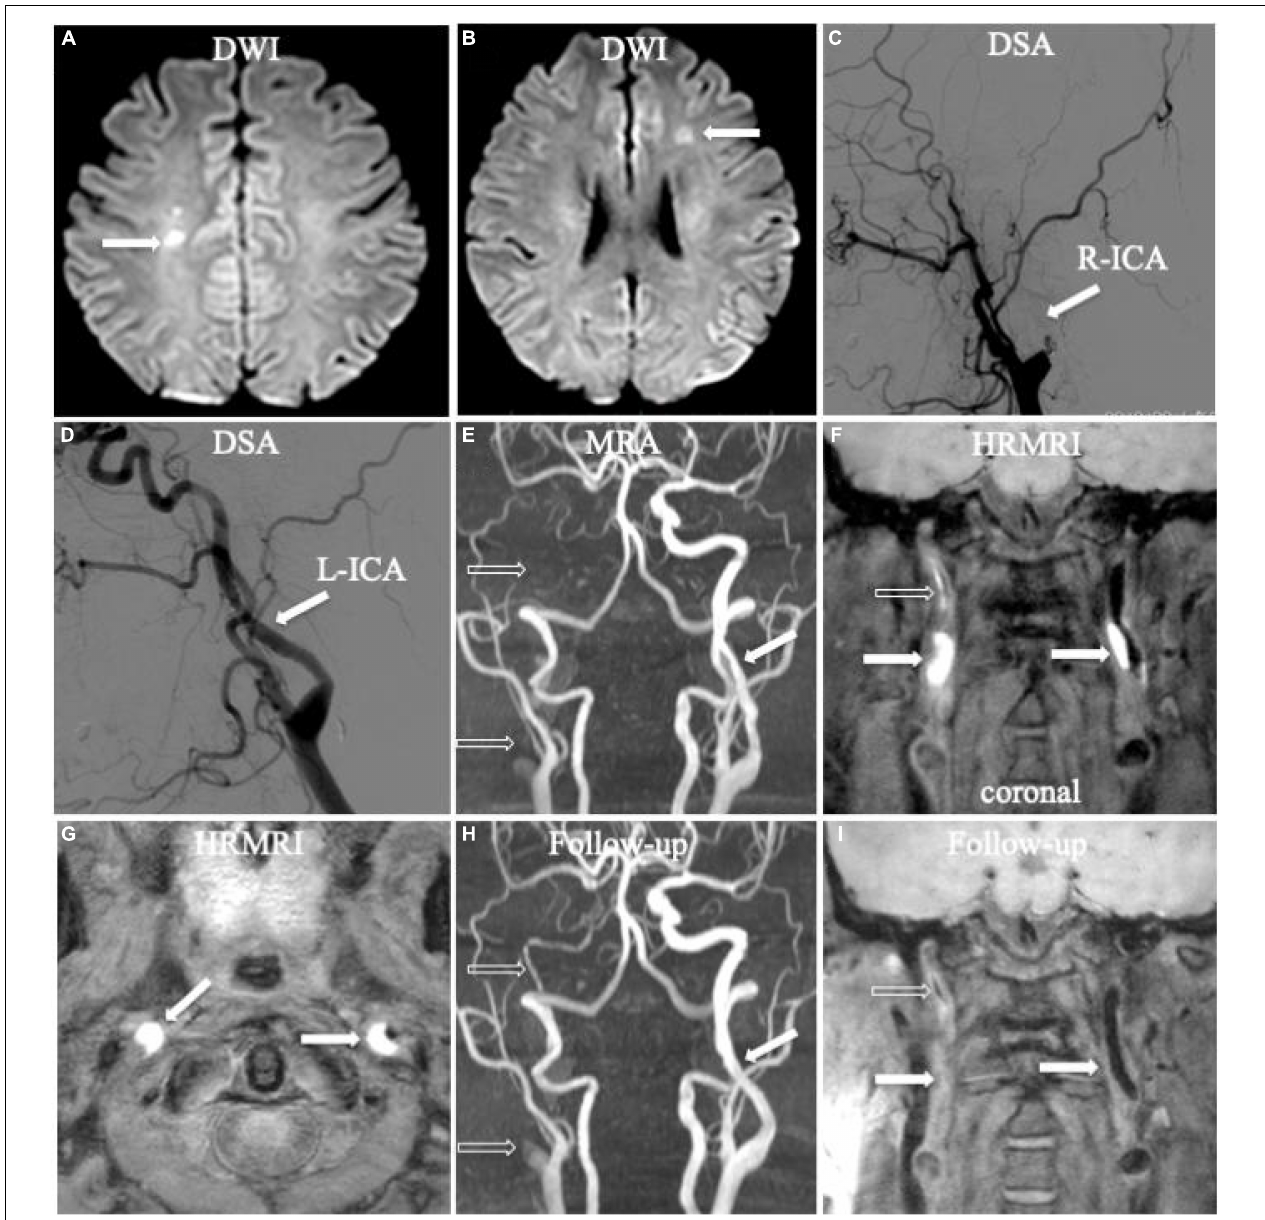
FIGURE 1 | Bilateral acute ischemic stroke associated with dissection in the internal carotid arteries (ICA) bilaterally. Diffusion-weighted imaging (DWI) showed acute ischemic stroke in bilateral hemispheres ( A,B , arrow). Digital subtraction angiography (DSA) only showed occlusion in the right ICA ( C , arrow) and mild irregular stenosis in the left ICA ( D , arrow) without any direct dissecting signs. Initial magnetic resonance angiography (MRA) displayed occlusion ( E , empty arrow) in the right ICA and mild irregular stenosis in the left ICA ( E , arrow), similar as the founding on DSA. Initial coronal T1-weighted high-resolution magnetic resonance imaging (HRMRI) demonstrated a T1-hyperintense intramural hematoma ( F , arrow) in the proximal C1 segments of the ICA bilaterally and a T1-hyperintense intraluminal thrombus in the middle and distal right ICA ( F , empty arrow). Transverse HRMRI presented with typical crescent-shaped intramural hematomas ( G , arrow). Follow-up MRA showed partial recanalization in the middle and distal right ICA ( H , empty arrow) and a nearly normal lumen in the left ICA ( H , arrow). Follow-up coronal HRMRI exhibited disappearance of the T1-hyperintense intramural hematoma ( I , arrow) in the ICA bilaterally and T1-hyperintense intraluminal thrombus ( I , empty arrow) in the right